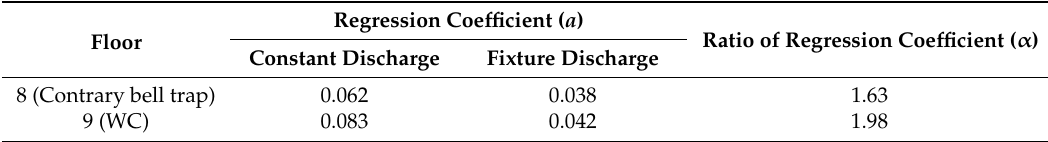
Figure 11. The scatter diagram and primary regression equation for the minimum pressure in the pipe and the seal loss in each load type. Table 5. Regression coefficient a and the ratio of regression coefficient of the constant discharge to the fixture discharge α.